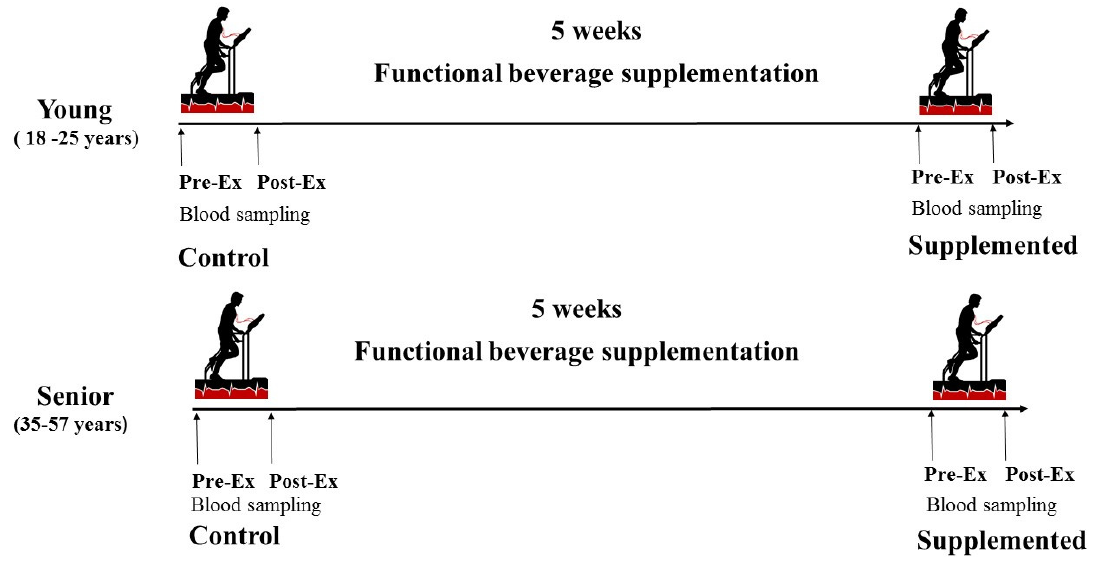
Figure 1. Diagram of the treatment time line.